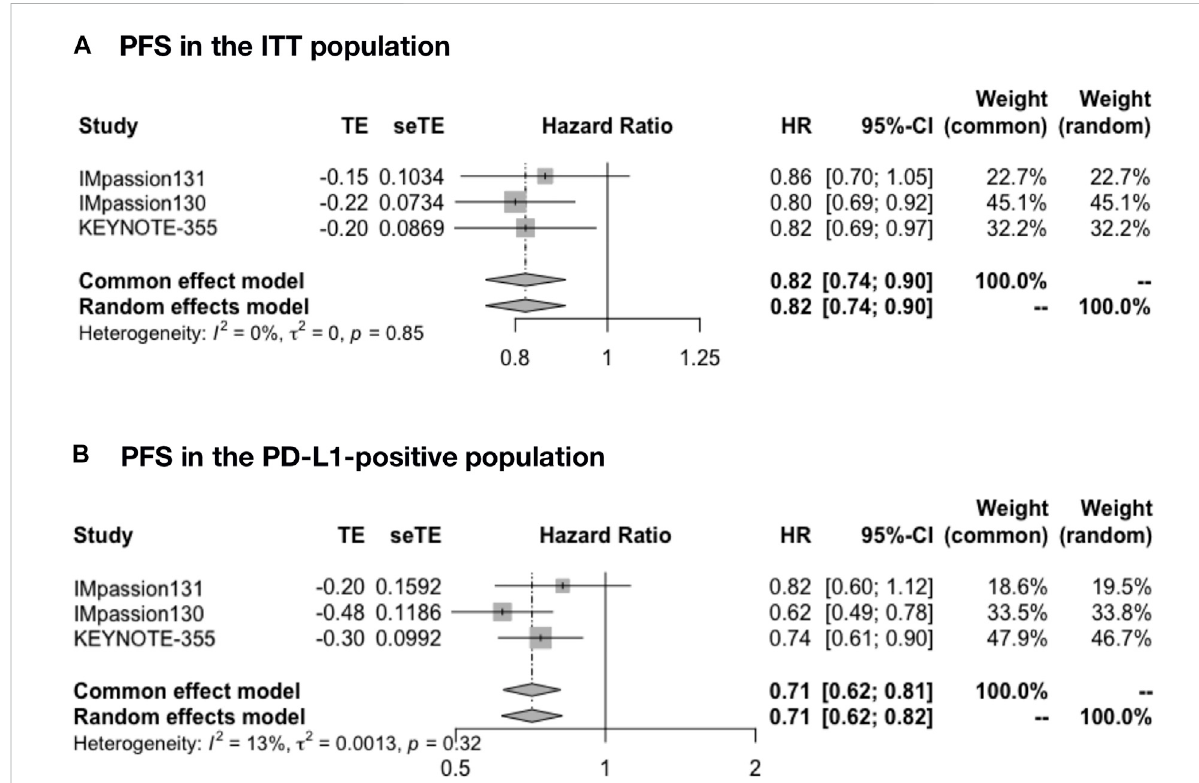
FIGURE 2 Pooled PFS in adjuvant therapy clinical trials. (A) PFS pooled results in the ITT population in the comparison of ICIs plus CT versus placebo plus CT. (B) PFS pooled results in the PD-L1-positive population. PFS, progression-free survival; ITT, intent-to-treat; HR, hazard ratio; 95% CI, 95% con fi dence interval; ICIs, immune checkpoint inhibitors; CT,